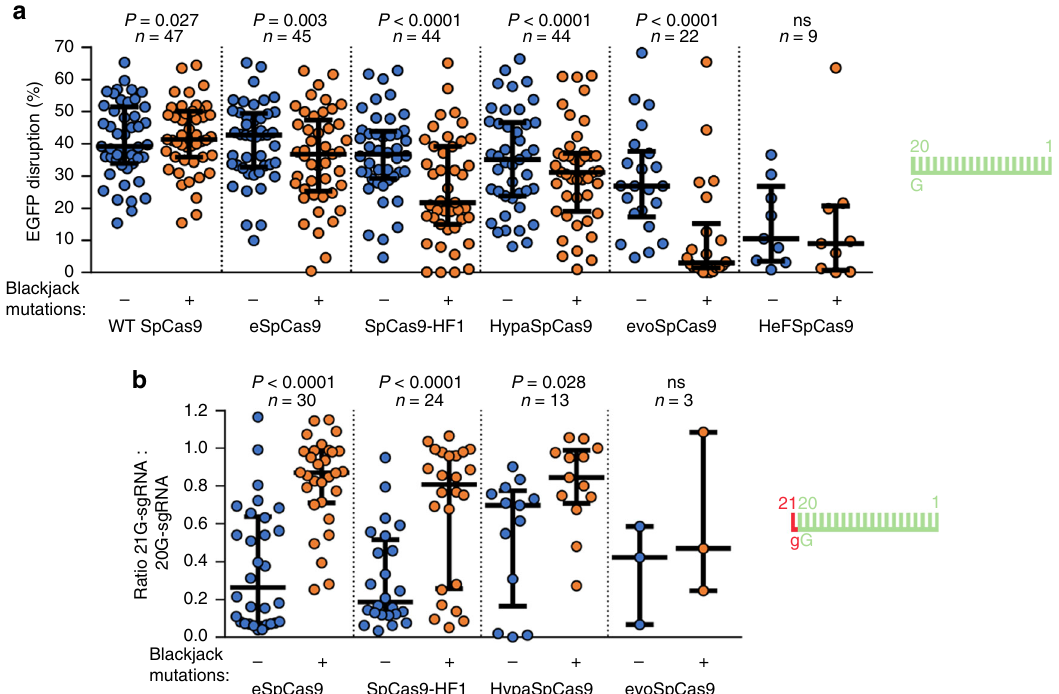
Fig. 2 The Blackjack mutations increase not only the activity of increased fi delity nucleases charged with 21G-sgRNAs, but their target-selectivity in general. a Blackjack mutations increase the target-selectivity of their respective parent SpCas9 variants. EGFP-disruption activities with perfectly matching 20G-sgRNAs. Results are shown only for those target sites where the SpCas9 variant without Blackjack mutations exhibits higher than background level cleavage. See also Supplementary Fig. 2. b On-target activities with 21G-sgRNAs on more target sites for which the SpCas9 variant with Blackjack mutations using 20G-sgRNAs exhibits at least 70% on-target activity compared to WT SpCas9. No target corresponds to this condition in the case of HeFSpCas9. See also Supplementary Fig. 3. a , b The median and the interquartile range are shown; data points are plotted as open circles representing the mean of biologically independent triplicates. Spacers are schematically depicted beside the charts as combs: green color teeth indicate matching-, while a red color tooth indicates the presence of an appended nucleotide within the spacer; numbering of tooth position corresponds to the distance of the nucleotide from the PAM; the starting 20th nucleotide of the spacer is indicated by an uppercase letter and an appended 21st nucleotide by a red lowercase letter. Statistical signi fi cance was assessed using two-sided Paired-samples Student ’ s t -test or two-sided Wilcoxon signed ranks test as appropriate; ns not signi fi cant. A summary of data distributions and statistical details is reported in Supplementary Data